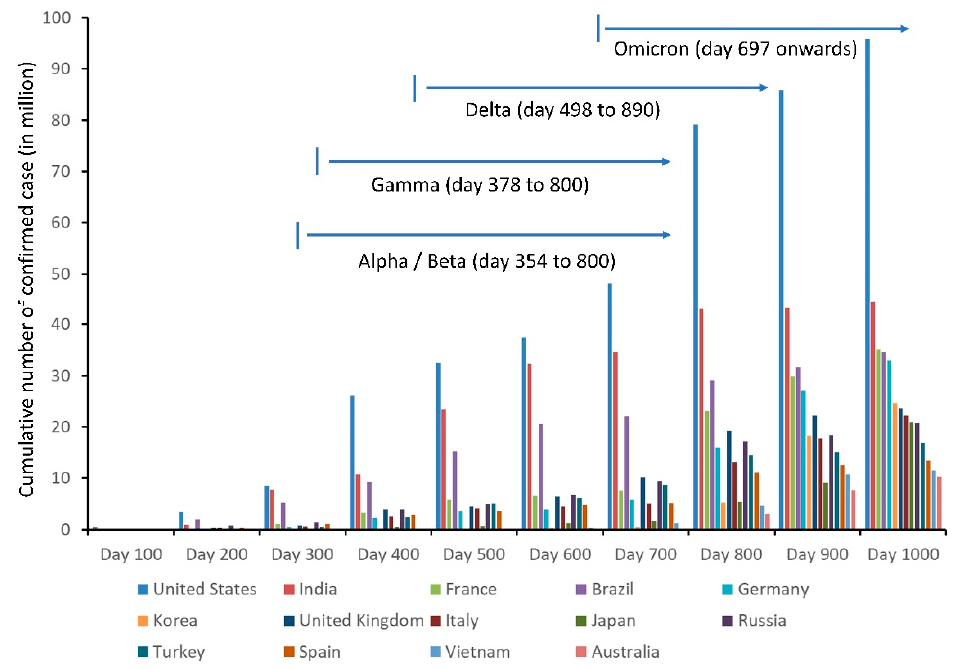
Figure 1. Cumulative number of COVID-19 cases in 14 countries reporting more than 10 million cases as of 25 September 2022 (day 1000).